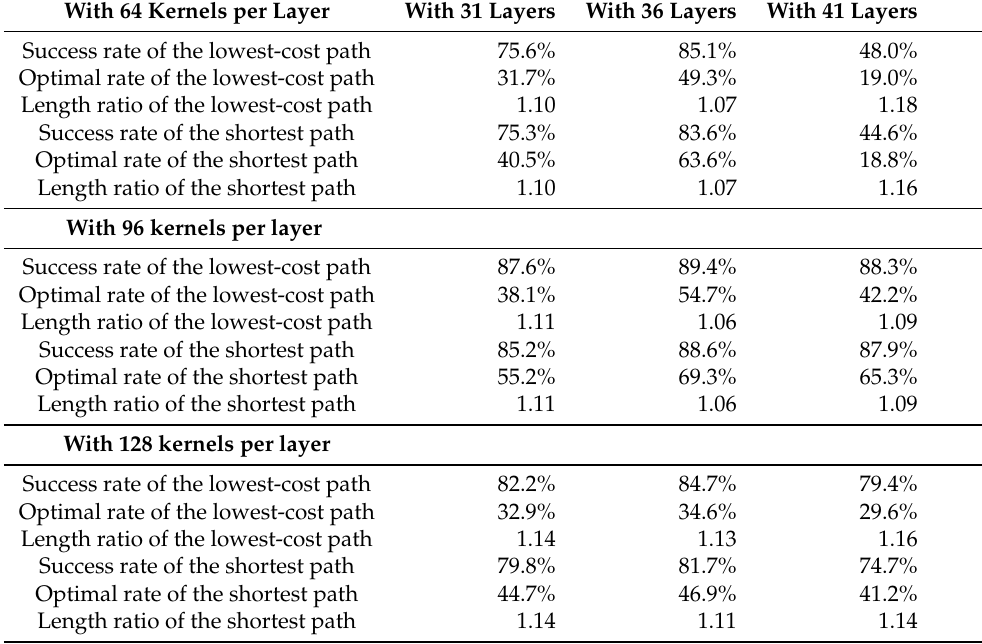
Table 1. Performance of the plain FCNN